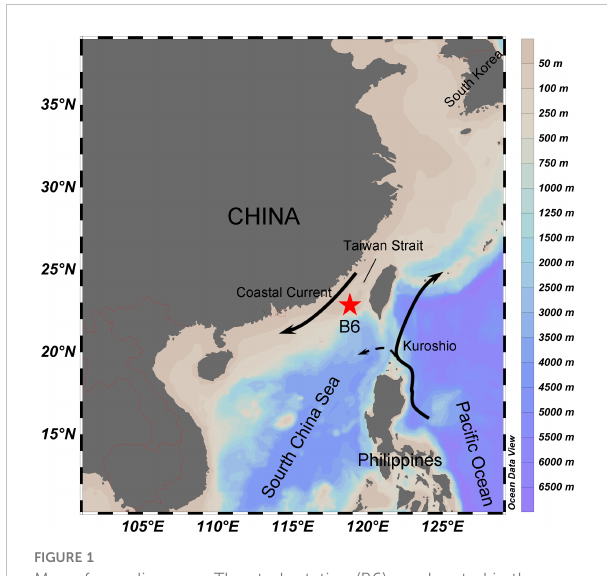
FIGURE 1 Map of sampling area. The study station (B6) was located in the southern of Taiwan Strait, off the west coast of Guangdong province,